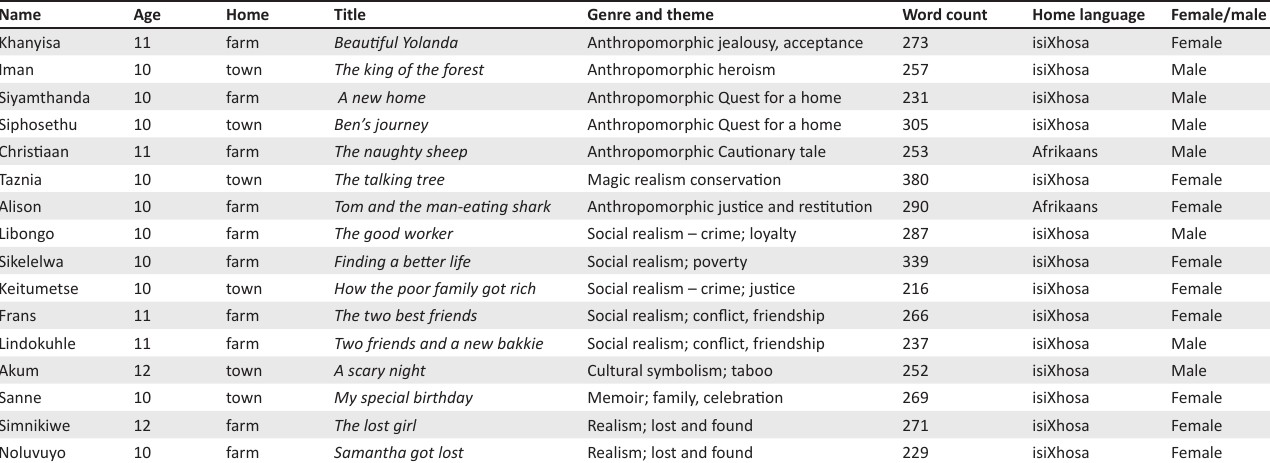
TABLE 2: Schedule of Grade 4 learners’